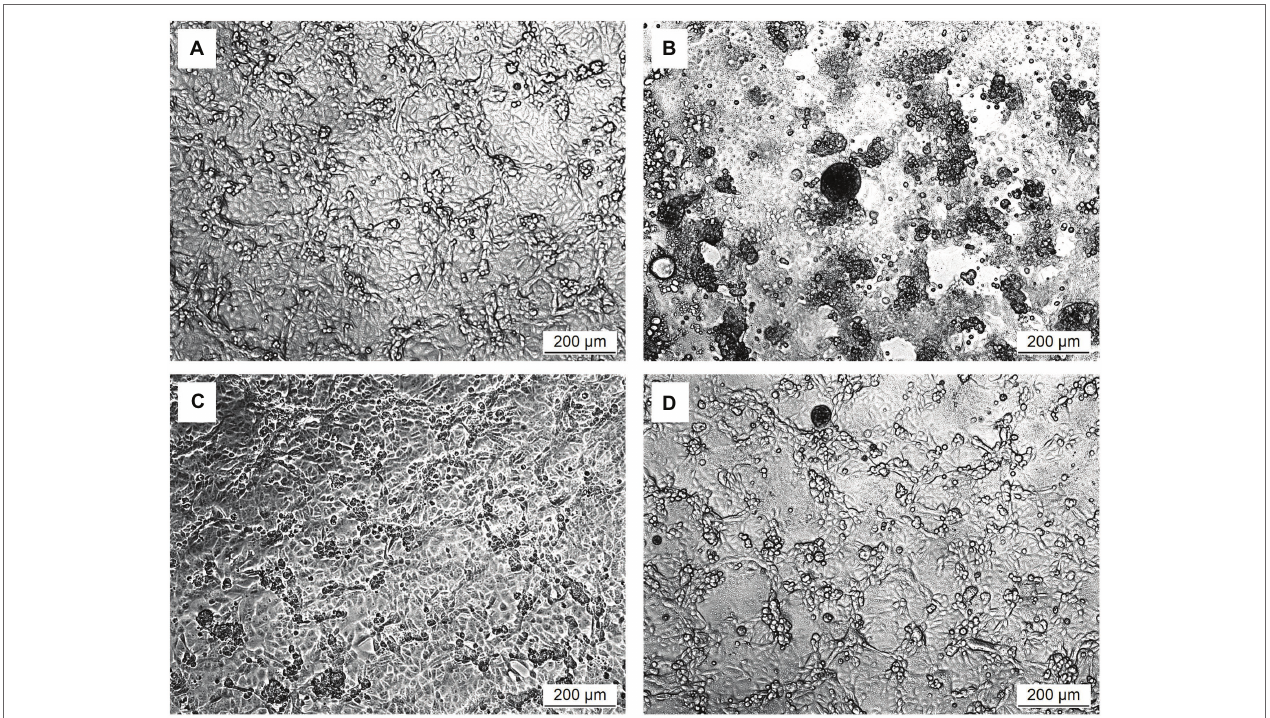
FIGURE 2 | Microscopic observation of the effect of pretreatments on the development of cytopathic effects in Vero cells infected with PEDV. (A) Cells pretreated with PBS and then mock-infected with PBS. (B) Cells pretreated with PBS and then infected with PEDV. (C) Cells pretreated with IFN- α 2b and then infected with PEDV. (D) Cells pretreated with the intracellular extracts of Ln. mesenteroides isolated from kefir grains and then infected with PEDV.